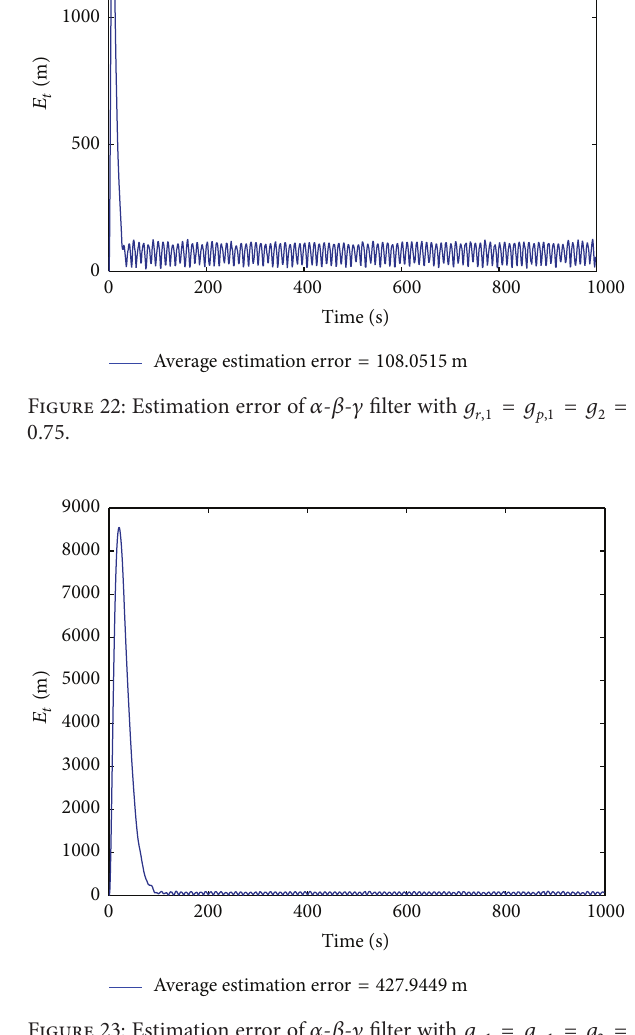
Figure 23: Estimation error of 𝛼 - 𝛽 - 𝛾 filter with 𝑔 𝑟,1 = 𝑔 𝑝,1 = 𝑔 2 = 0.9